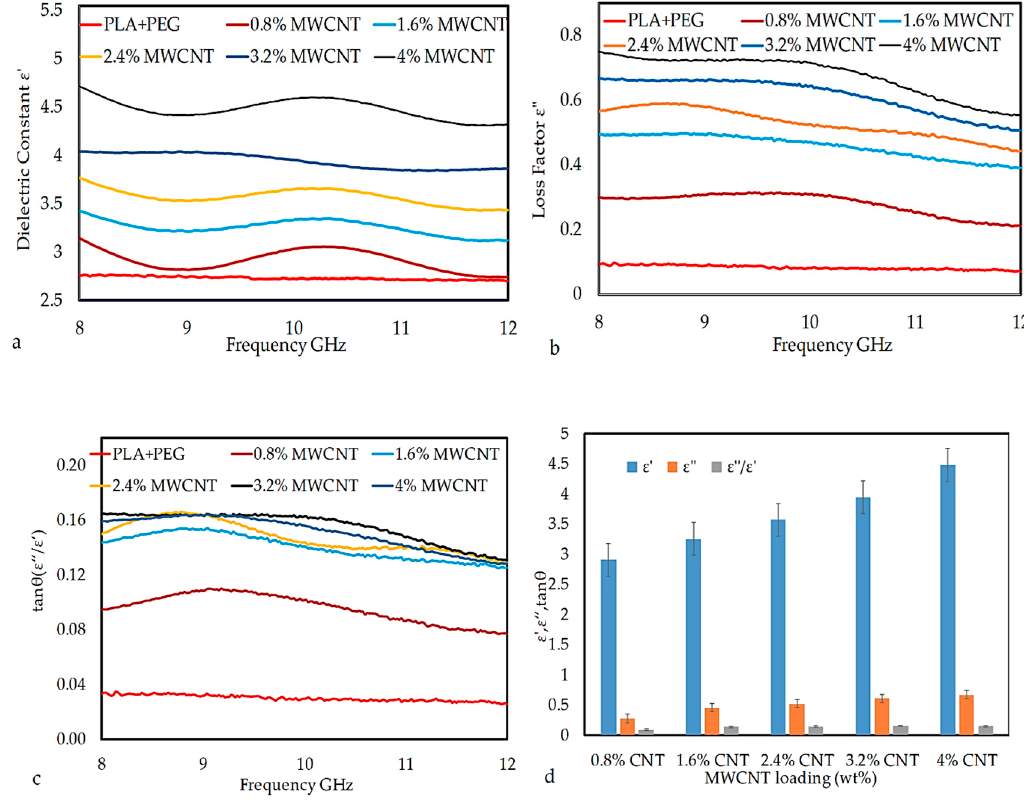
Figure 10. The plot of ( a ) ε (cid:48) , ( b ) ε (cid:48)(cid:48) , ( c ) tan δ vs. frequency, and ( d ) comparison of ε (cid:48) , ε ”, and tan δ as a function of MWCNTs nanoparticle loading at MWCNT/PLA/PEG nanocomposites.